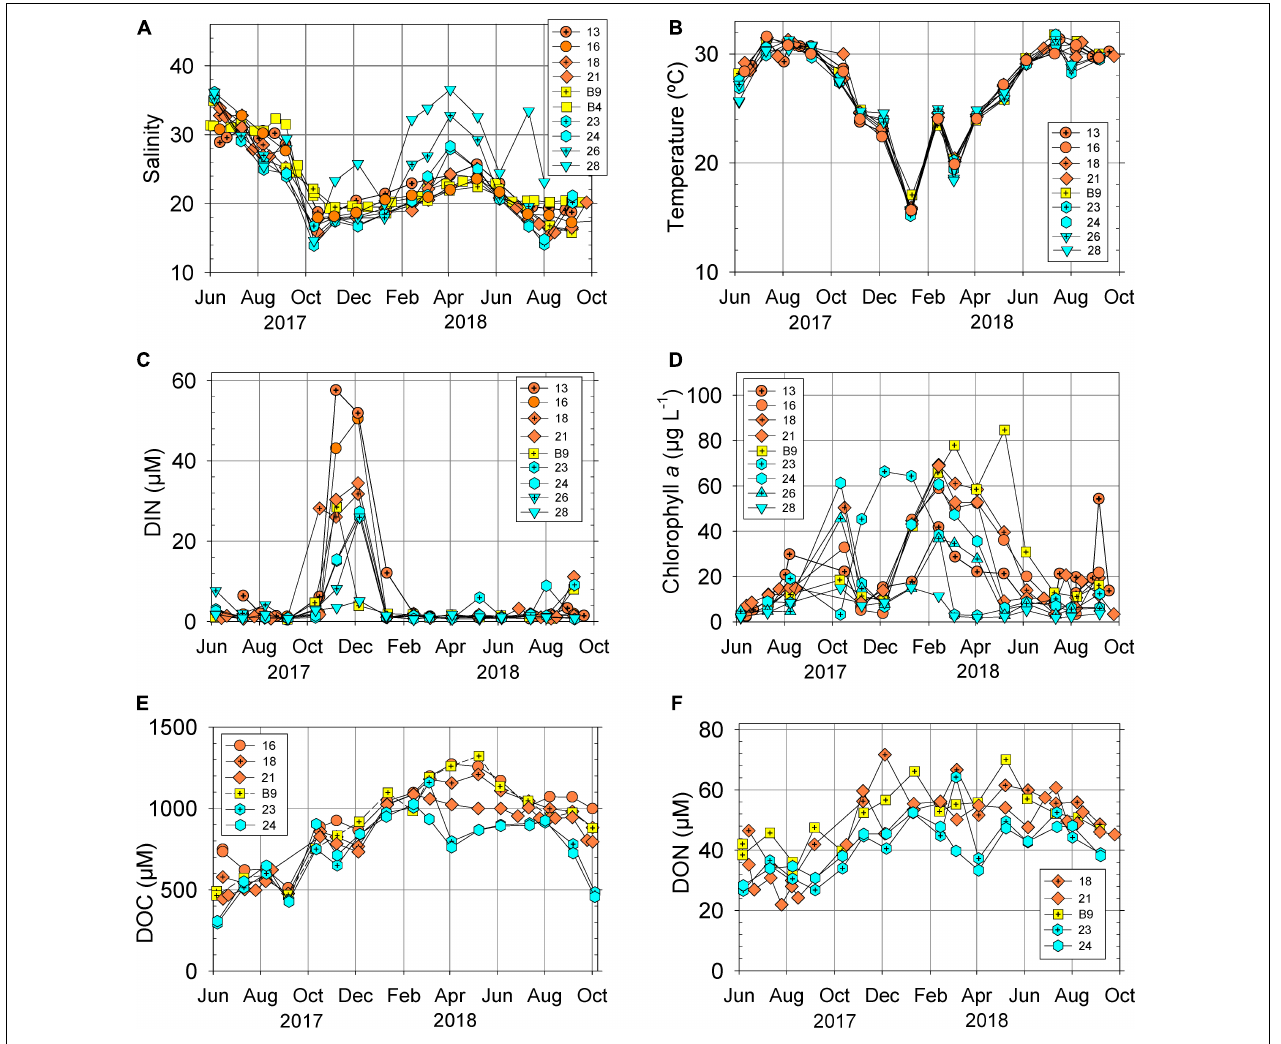
FIGURE 6 | (A) Salinity, (B) temperature, (C) dissolved inorganic nitrogen (DIN), (D) chlorophyll a , (E) dissolved organic carbon (DOC) and (F) dissolved organic N (DON) for stations in the Indian River Lagoon (IRL) and Banana River Lagoon (BRL). Data from St. Johns River Water Management District [SJRWMD] (2020b). Markers are color coded as orange (North IRL), yellow (BRL) and blue (Central